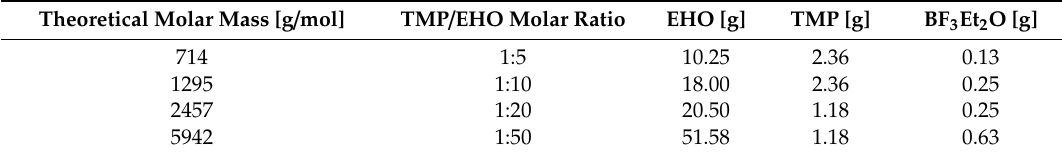
Figure 4. 1 H NMR (400 MHz, DMSO-d 6 ) spectra of the studied polyoxetanes.